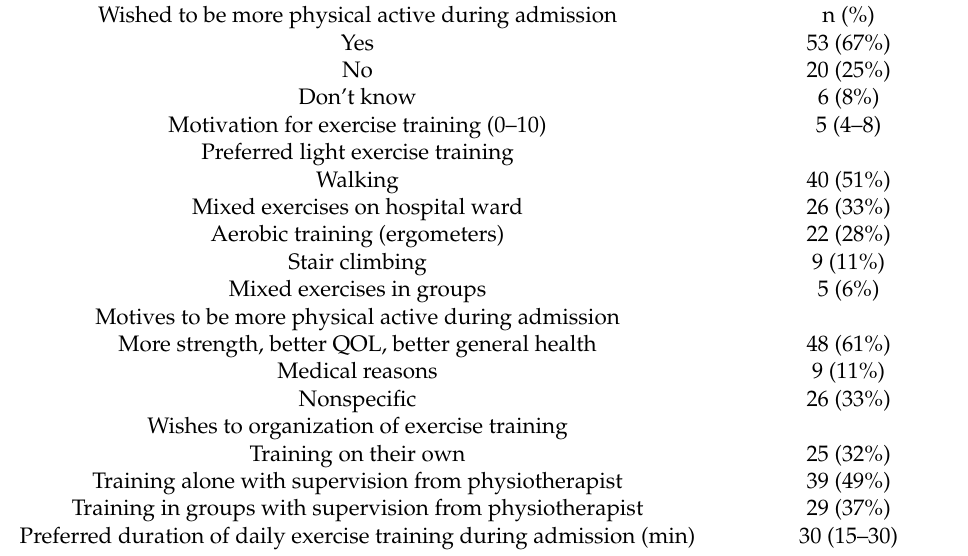
Table 3. Motives to be physical active during